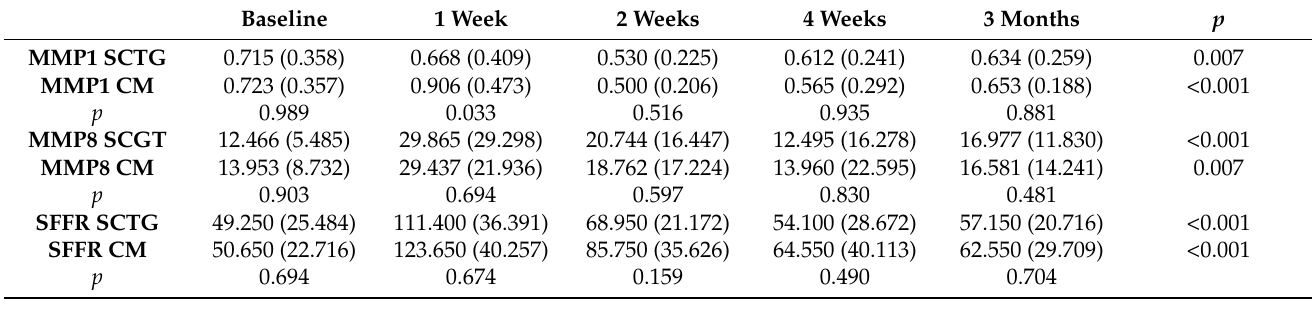
Table 1. MMP levels and SFFR (mean and SD) at relevant stages of study.